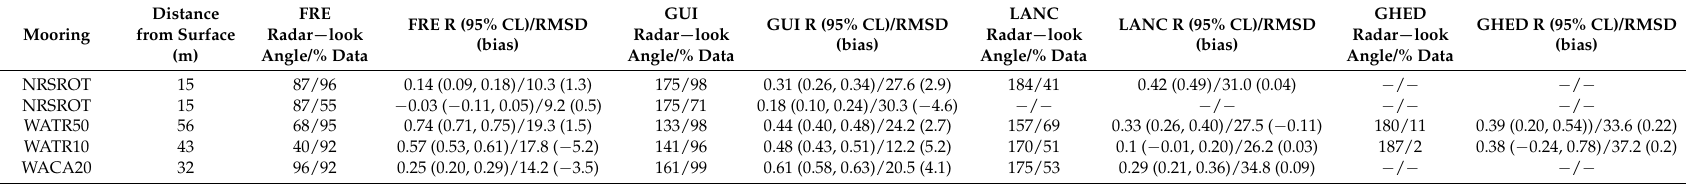
Table 2. Comparison of surface HFR and subsurface radial data for the WERA and SeaSonde HFR stations. Radar look angle in the direction of the mooring (counterclockwise north) is also provided along with percent data available for the comparisons. R is the correlation coefficient between radial velocities as defined in Equation (1). Units for RMSD (bias) are cm/s.